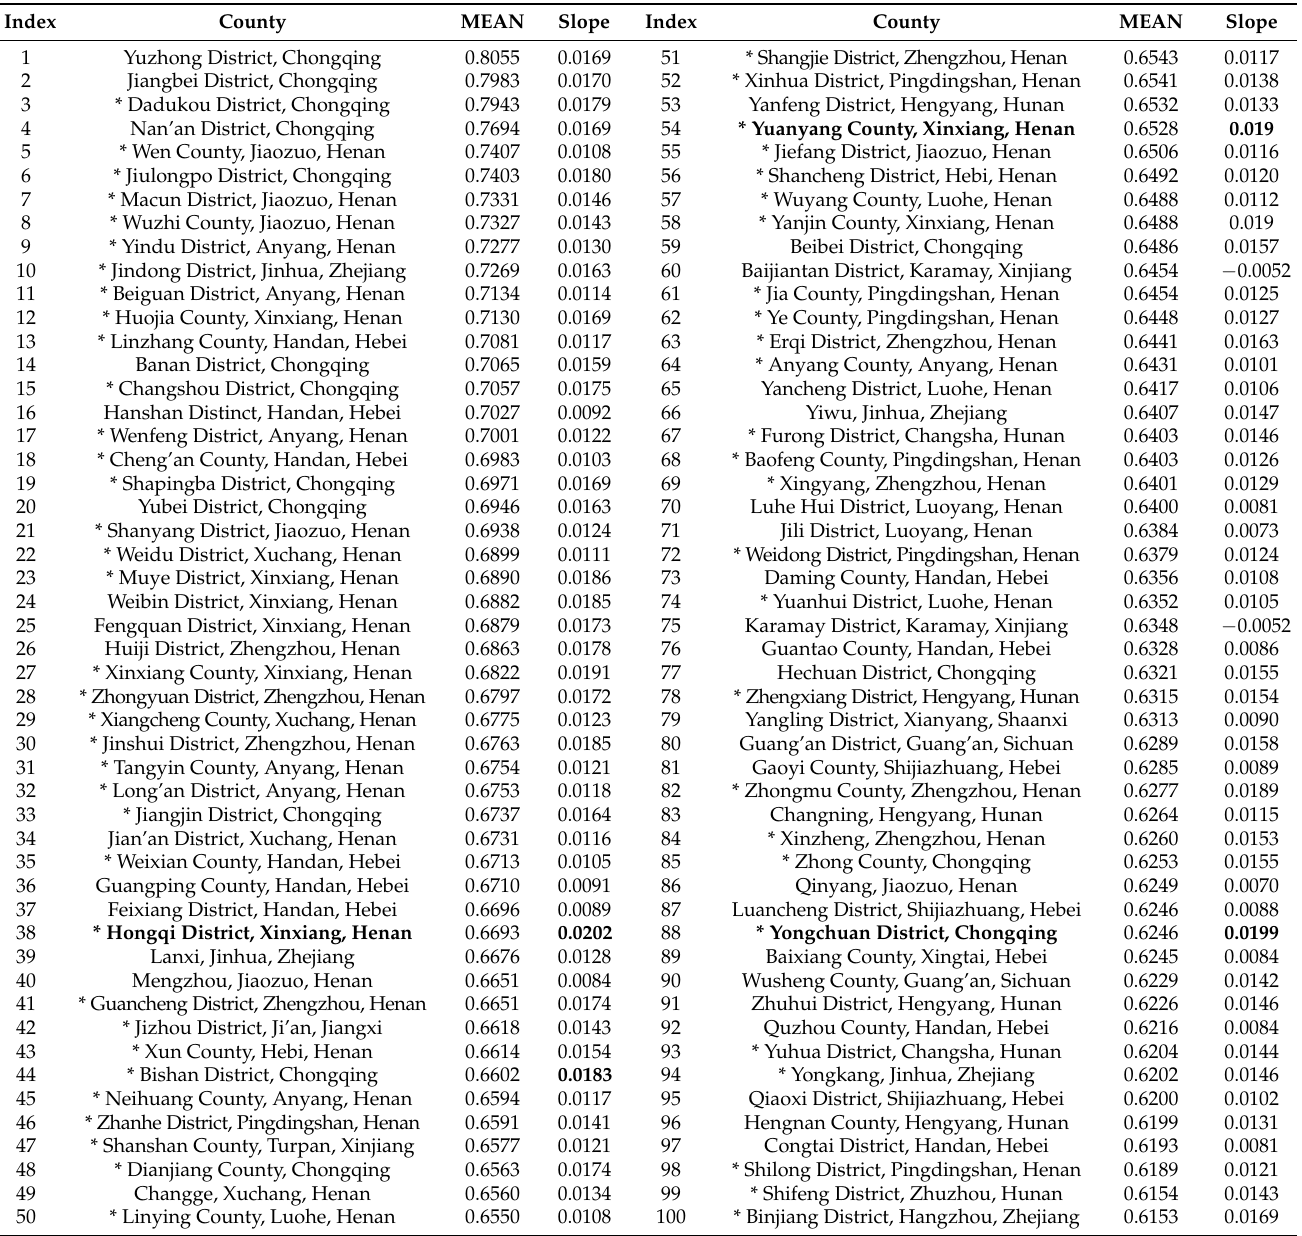
Table A2. Top 100 counties by AH